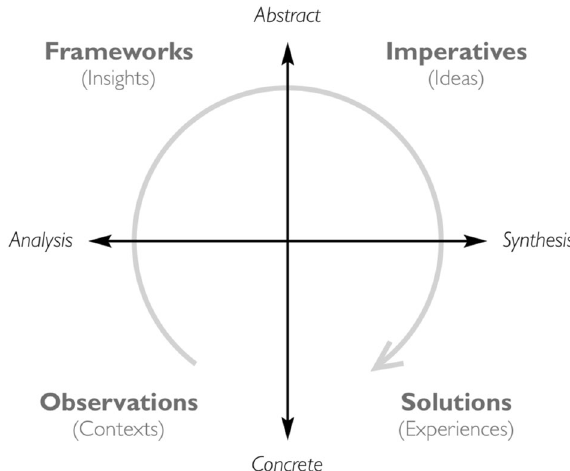
Fig. 2 Innovation process as adapted from Beckman and Barry